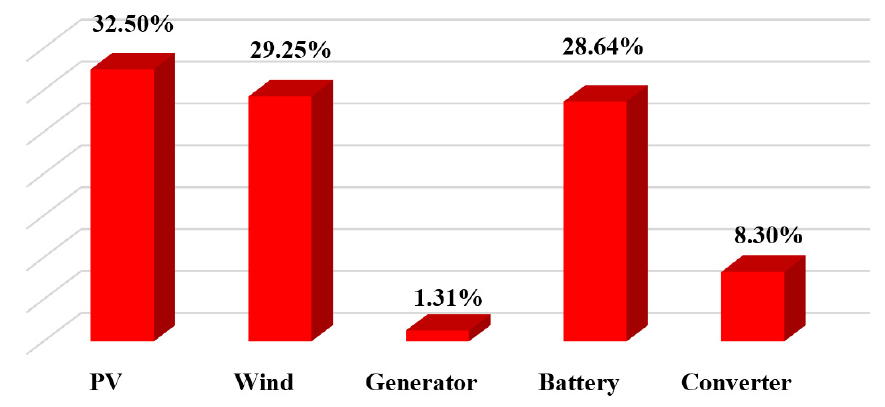
Figure 11. Cost of each component of the optimum HRES as a percentage.